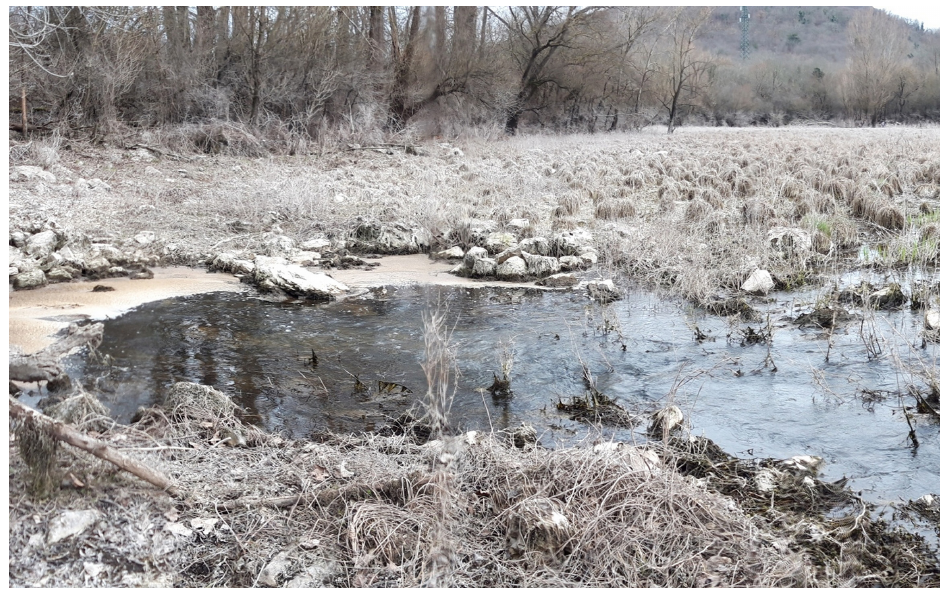
Figure 3. Carex elata tussocks and other vegetation types covered with lacustrine sediment near a swallow hole in the NE sector of the lake basin immediately after a period of flooding in